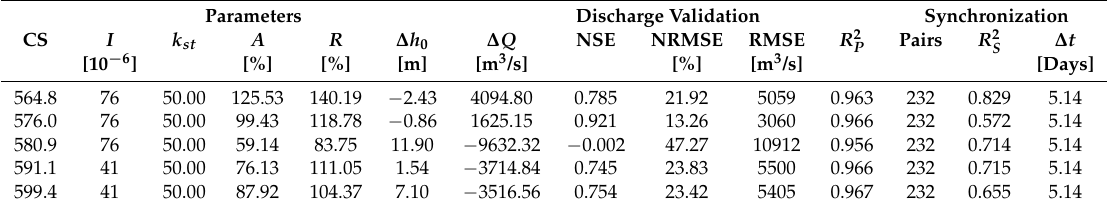
Estimated Parameters (left), discharge validation results (center), and observations synchronization statistics (right) at Natchez using combined altimetry data from E4, J1, S5, and S6. For details see Table 3.